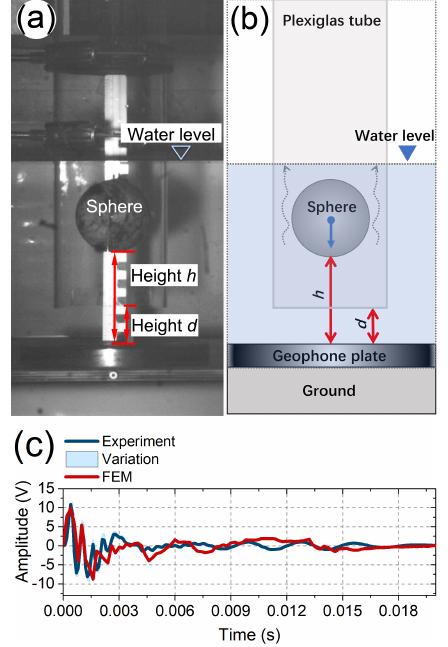
Figure A1. (a) Side-view photo (Gaillard, 2018) and (b) sketch (taken from Chen et al., 2021, 2022) of the drop-test setup used in earlier laboratory tests to measure the impact velocity. h is the distance between the bottom surface of the sphere and the plate, and d is the distance between the bottom of the Plexiglas tube and the plate. The tube protects the sphere from flow turbulence in cases where the setup is used at field sites. (c) Comparison of the FEM signal and the experimentally generated signal (from the drop test) in the Z direction (perpendicular to the plate and point- ing up), which was triggered by a single bedload particle (diameter D = 120mm) impacting at a central location on the plate with a velocity of 0.777ms − 1